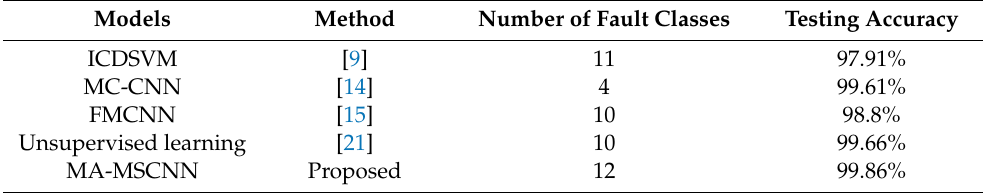
Table 6. Comparisons of classification accuracy of other researches on the same bearing